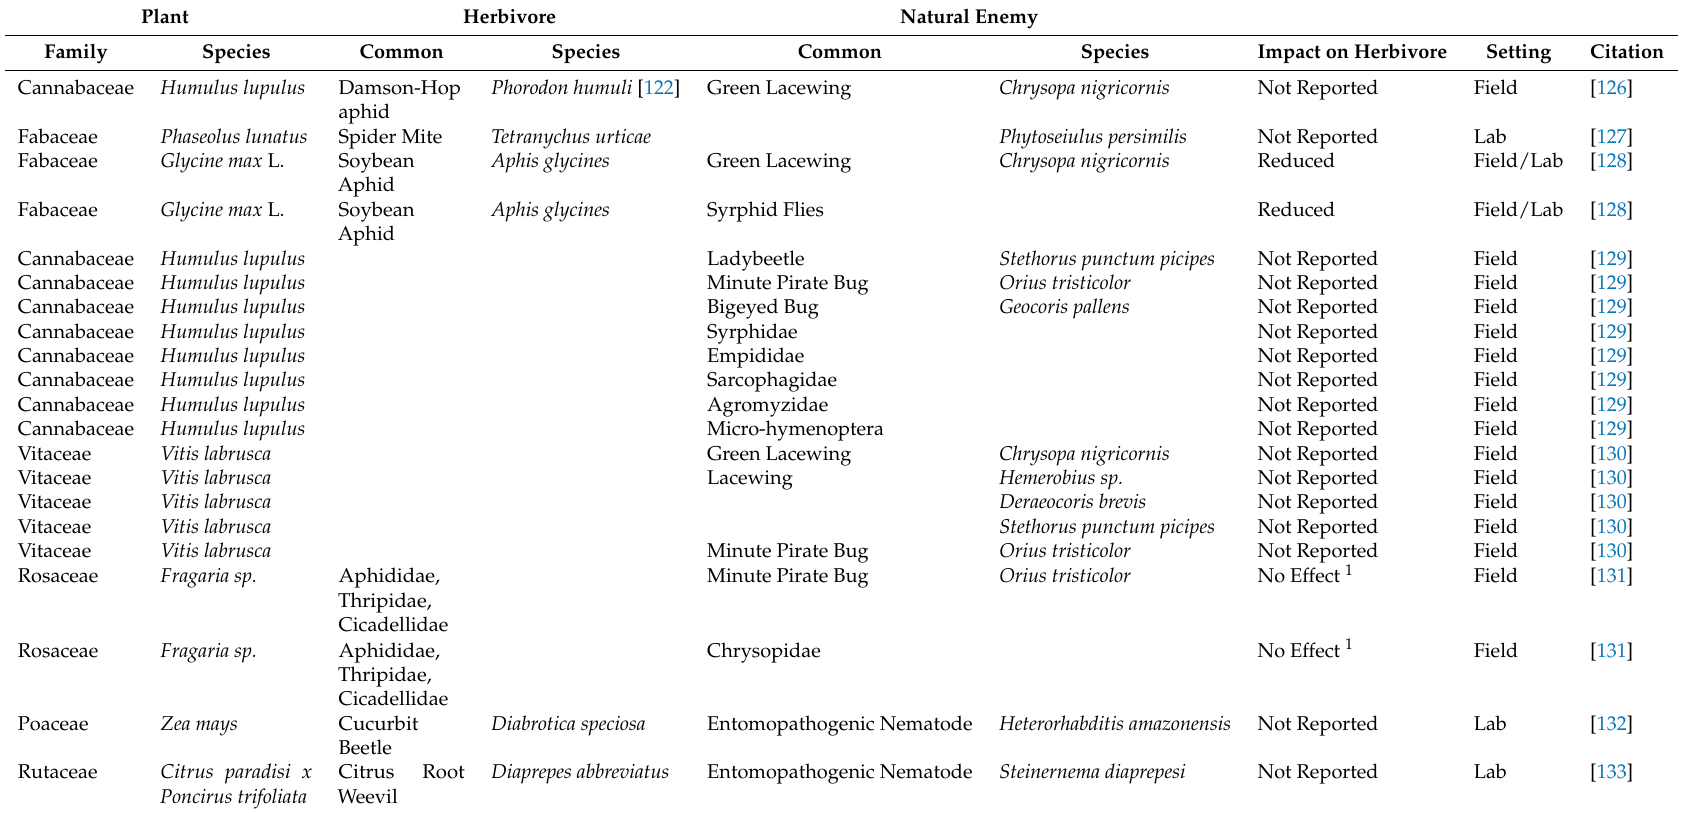
Table 2. Natural Enemies Recruited by